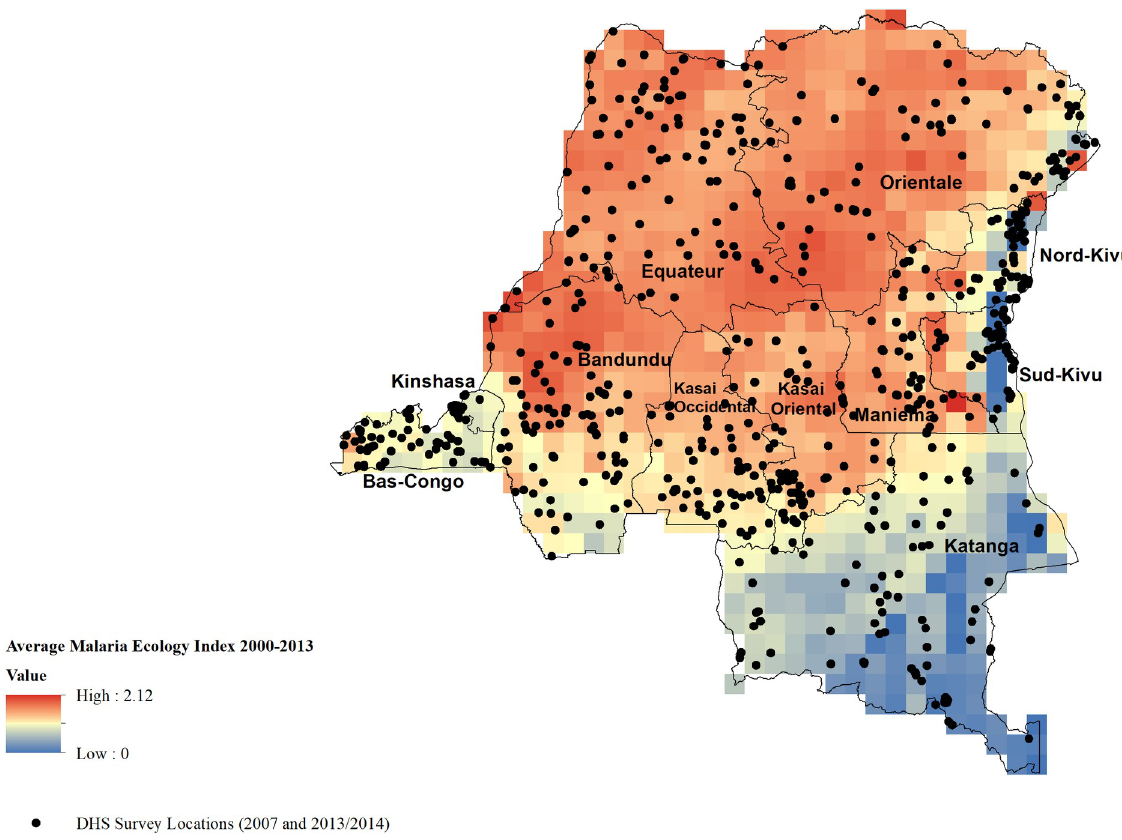
Fig 2. Average Malaria Ecology Index and Demographic Health Survey sampling